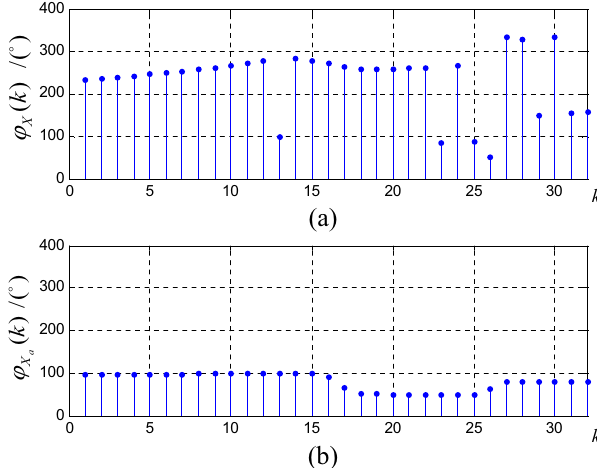
Figure 2. ( a ) Traditional 64-point DFT phase spectrum; ( b ) All-phase 64-point DFT phase